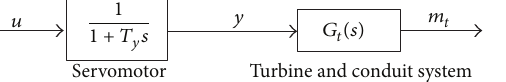
Figure 1: Dynamic model of turbine and conduit